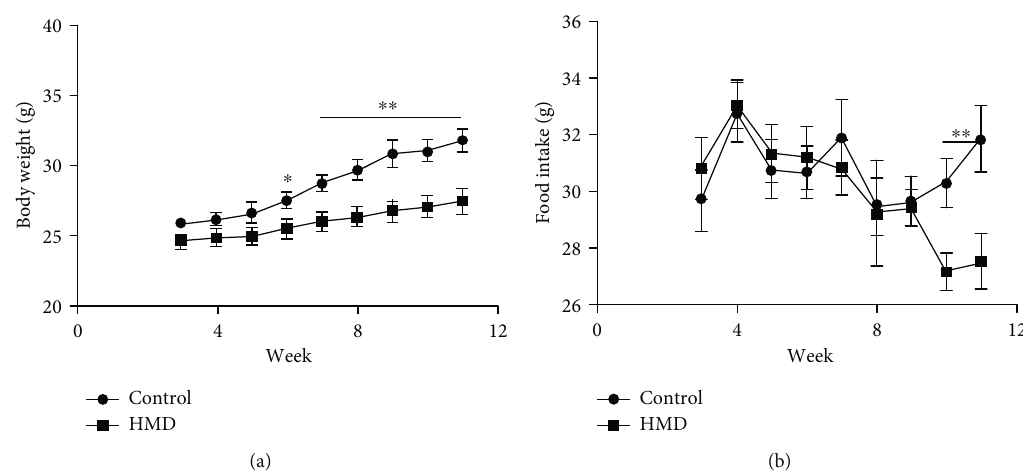
Figure 1: E ff ect of HMD on body weight and food intake. (a) The body weight of mice. (b) The food intake of mice. Note: the values were expressed as mean ± SEM ( n = 8 ). ∗ p < 0 : 05 , ∗∗ p < 0 : 01 vs. control